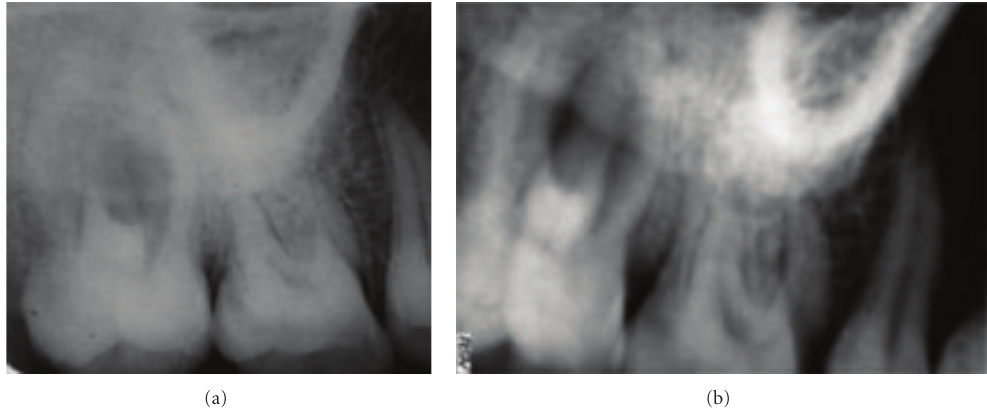
Figure 1: Preoperative radiograph with di ff erent angulations: complex root anatomy of maxillary right second molar.